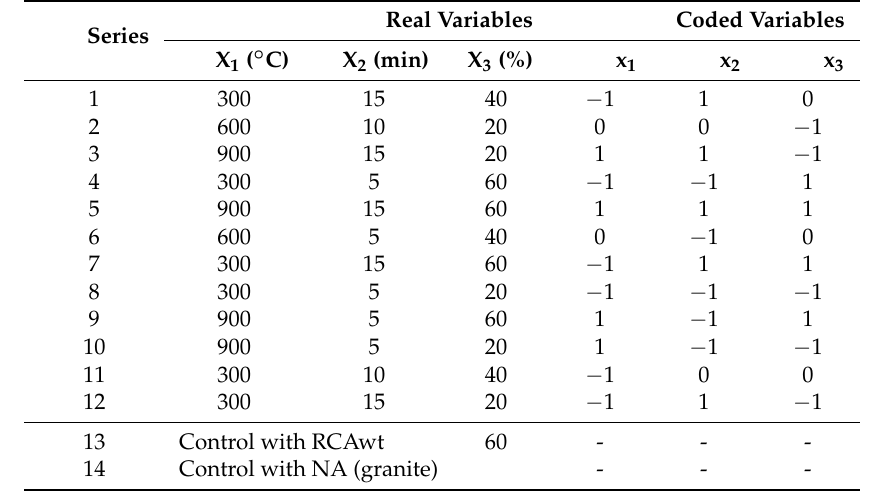
Table 5. Sequential Hartley’s PS/DS-P:Ha3 plan.